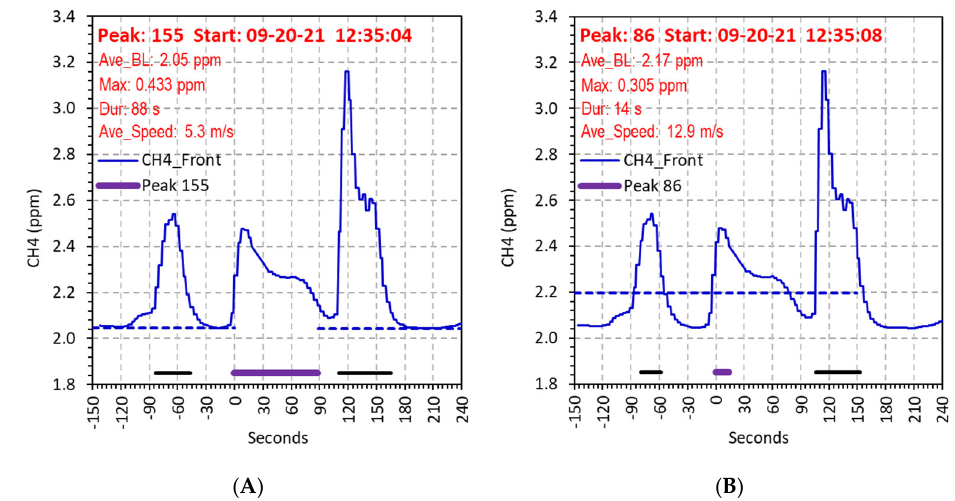
Figure 4. Comparison of the same peak detected by parameter set 4 ( A ) and the parameters by Weller et al. [21] ( B ). The peak stared at time 0 s and its duration is indicated by the solid purple bar. Solid black bars indicate additional peaks before and after, dashed blue bars indicate peak baseline levels and calculation window according to the corresponding methods. The entire trend plot includes 390 s measurements, which usually cover ~2000 m driving distance.